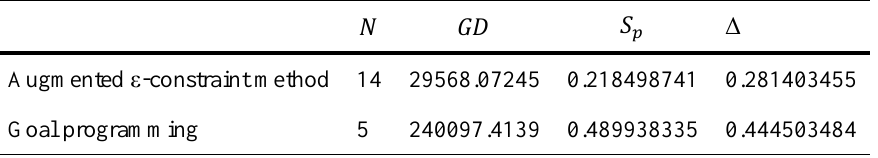
Table 5. Comparison of algorithms with respect to illustrative